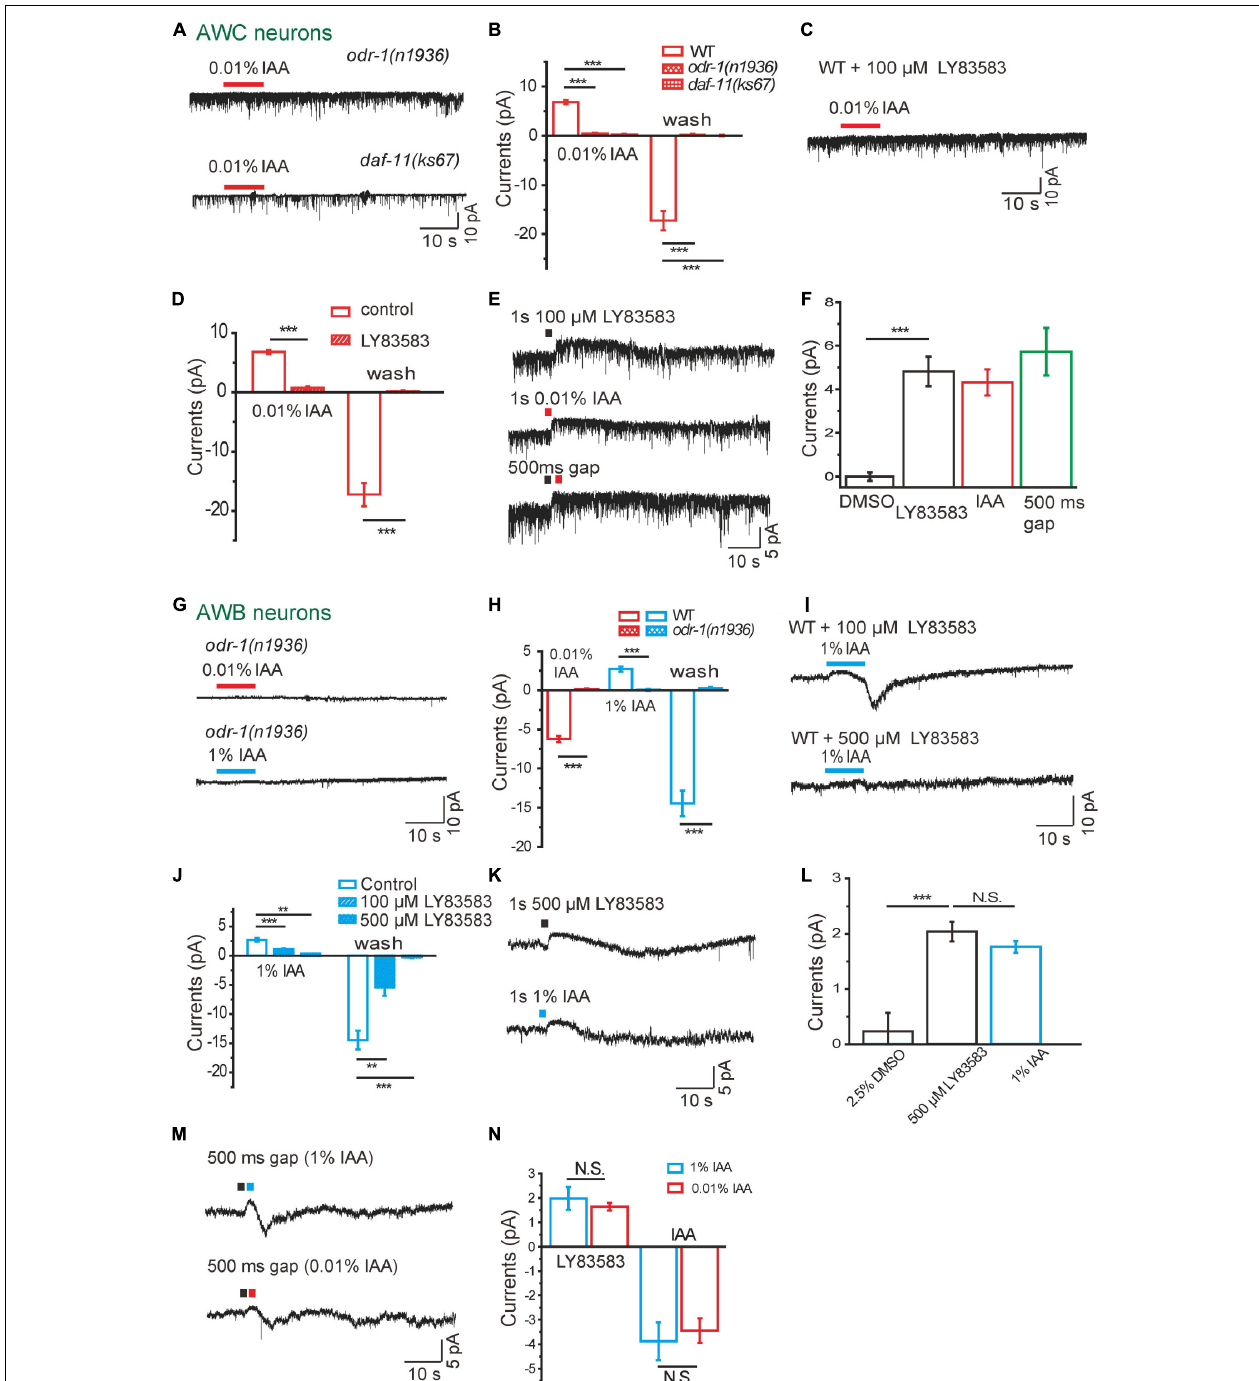
FIGURE 4 | Guanylate cyclases are required in intensity-dependent olfactory encoding. (A,B) 0.01% IAA-induced currents from AWC neurons were abolished in either odr-1(n1936) or daf-11(ks67) mutant background. (A) Representative traces. (B) Quantification of the currents. n ≥ 6. (C,D) 0.01% IAA-induced currents from AWC neurons were blocked by 100 µ M LY83583, a GC inhibitor, in the bath solution. (C) Representative traces. (D) Quantification of the currents. n ≥ 5. (E,F) A puff of either 100 µ M LY83583 or 0.01% IAA induced an outward current from AWC neurons. (E) Representative traces. Black square: LY83583. Red square: 0.01% IAA. No summation of the currents induced by LY83853 and 0.01% IAA was observed, when a puff of LY83583 was followed by a successive puff of IAA within 500ms interval. (F) Quantification of the currents. A puff of 0.5% DMSO was taken as negative control. n ≥ 4. (G,H) Neither 0.01% nor 1% IAA elicited detectable current from AWB neurons in odr-1(n1936) mutants. (G) Representative traces. (H) Quantification of the currents. n ≥ 7. (I,J) 1% IAA-induced currents from AWB neurons were blocked by LY83583. (I) Representative trace. (J) Quantification of the currents. n ≥ 3. (K,L) A puff of either 500 µ M LY83583 or 1% IAA induced